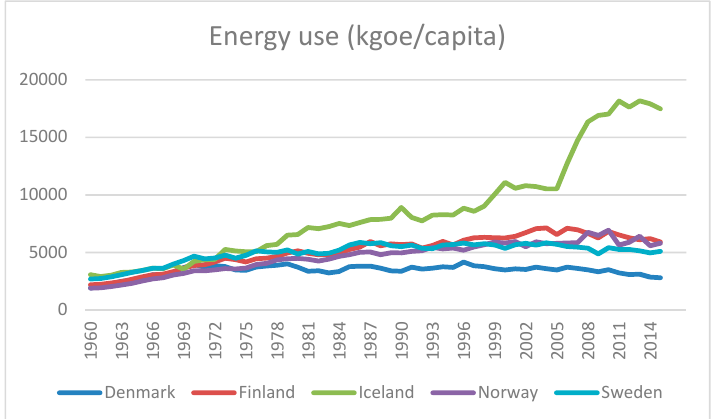
Figure 3. Energy use, measured in kg oil equivalents per capita, of the Nordic countries between 1960 and 2015. Data source: [44].